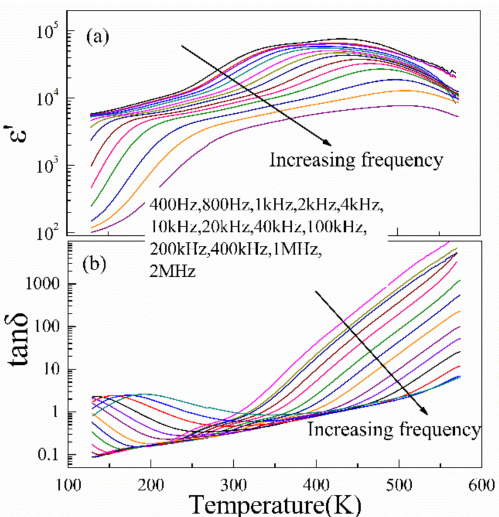
Figure 4. Temperature dependence of dielectric constant ( a ) and dielectric loss ( b ) for La 2/3 Cu 3 Ti 4 O 12 ceramics at various frequencies (400 Hz–2 MHz).